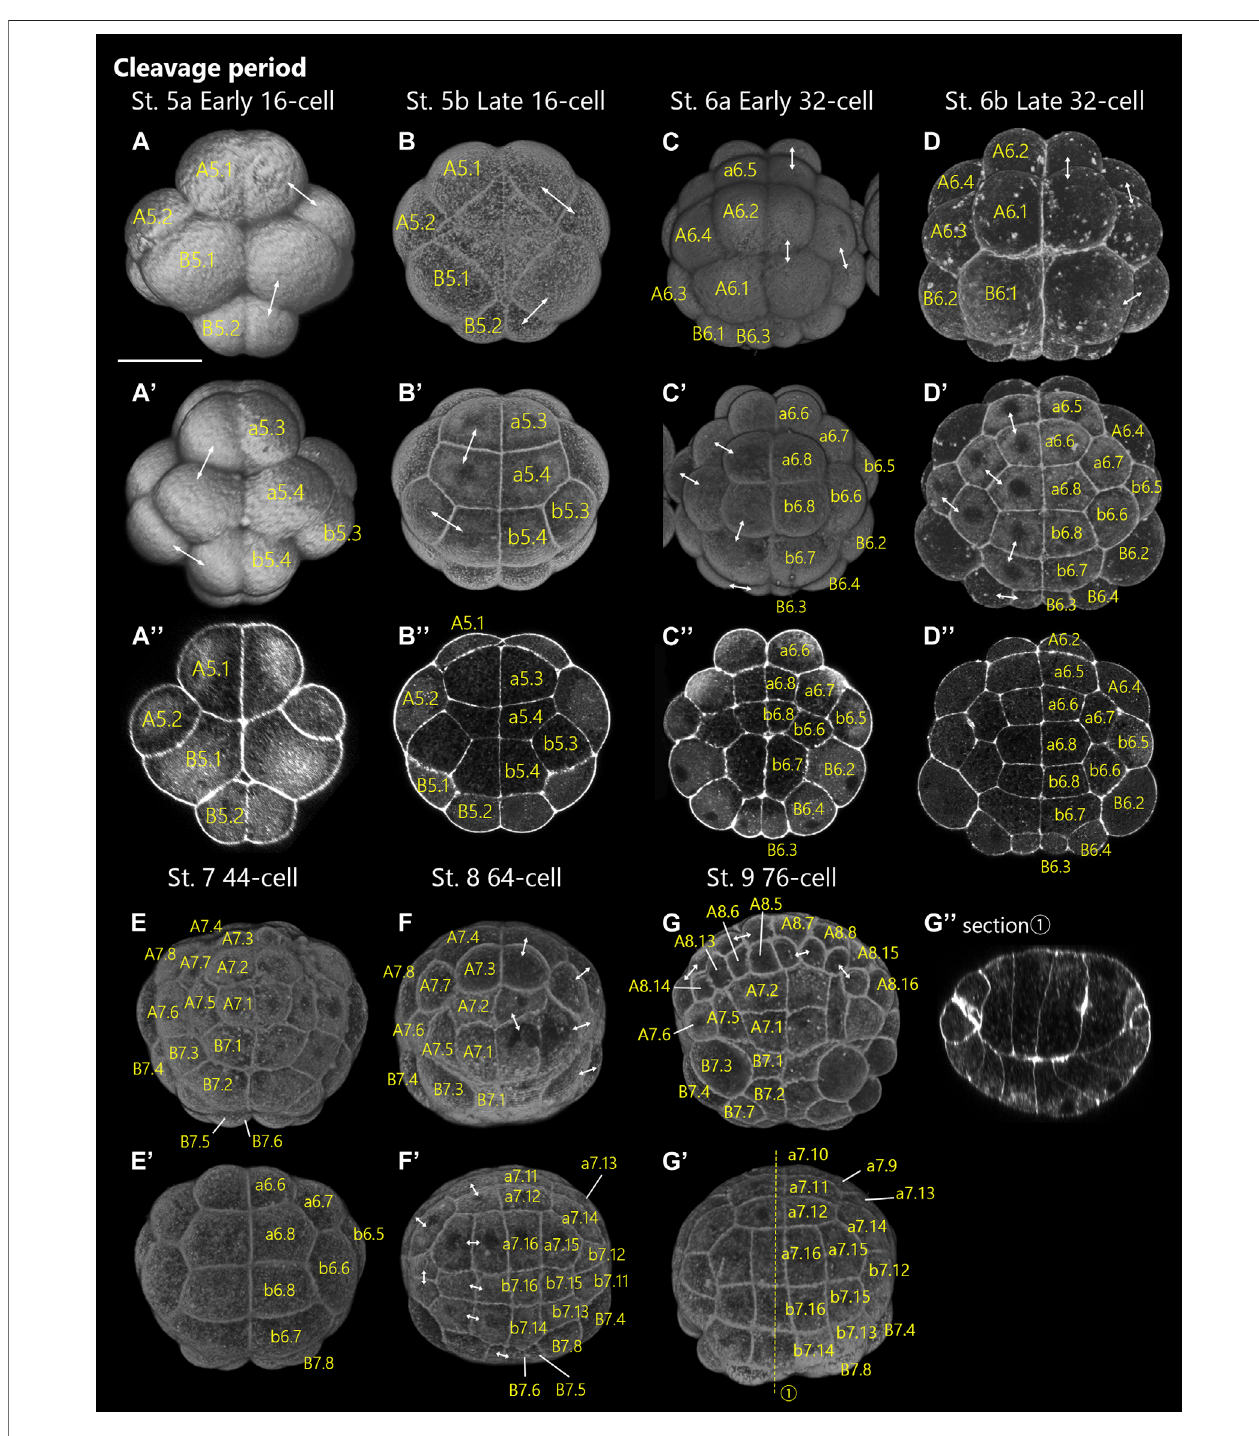
FIGURE 3 | Ascidiella aspersa embryos at the latter of cleavage period. Embryos are stained with Alexa Fluor ™ 546 Phalloidin. Three-dimensional reconstructed imagesat (A,A 9 ) Stage5a(early16-cell), (B,B 9 ) Stage5b(late16-cell), (C,C 9 ) Stage6a(early32-cell), (D,D 9 ) Stage6b(late32-cell), (E,E 9 ) Stage7(44-cell), (F,F 9 ) Stage8 (64-cell), and (G,G 9 ) Stage 9 (76-cell). (A – G) show the dorsal views of the embryos, and (A 9 – G 9 ) show the ventral views of the embryos. Panels (A 99 -D 99 ) are cross- sections of (A – D) , respectively. (G 99 ) shows longitudinal sections of (G,G 9 ) . The positions of the sections are indicated by dashed lines in (G 9 ) . Anterior side of each embryo is up except for (G 99 ) (vegetal side is up in (G 99 ) . Two-headed arrows indicate the pair of daughter cells. The number of cell-lineages are drawn on each blastomere. Scale bar: 50 μ m.